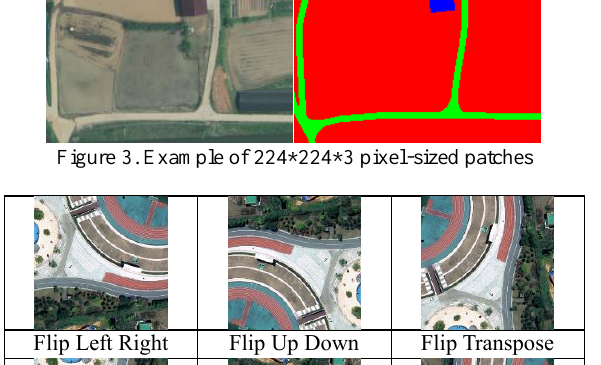
Flip Left Right Flip Up Down